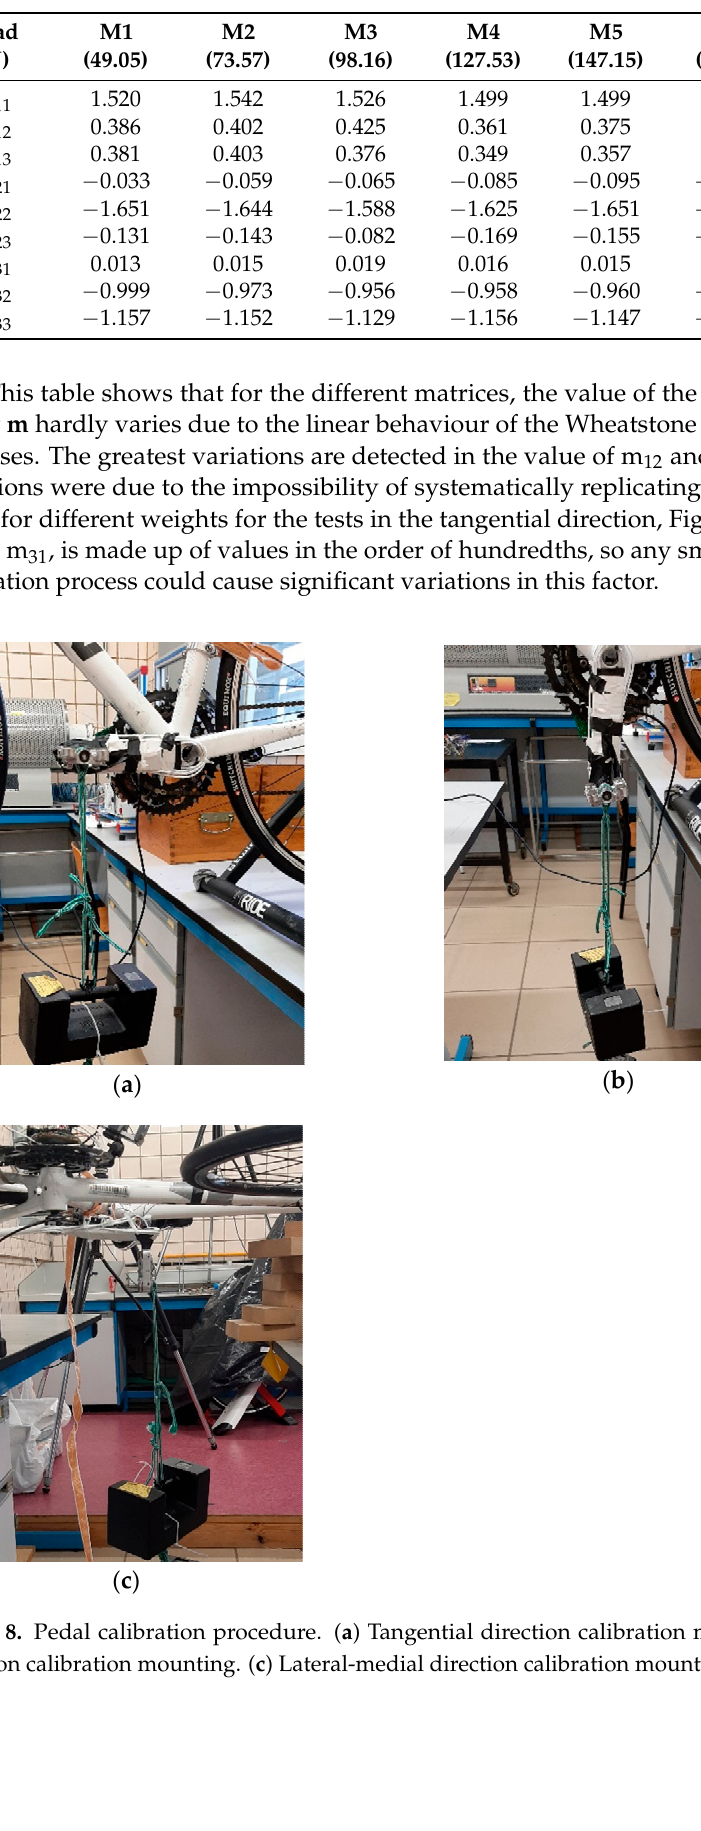
Table 2. Components of the M matrix for different calibration loads.